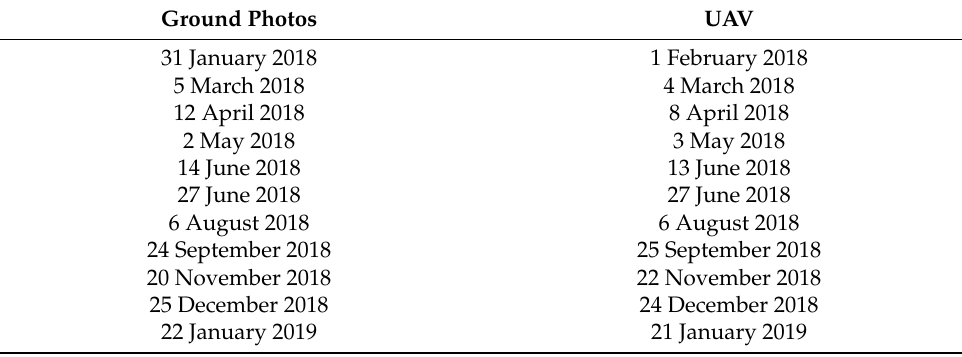
Table 3. UAV data acquisition dates and adjacent dates of ground photography. Ground